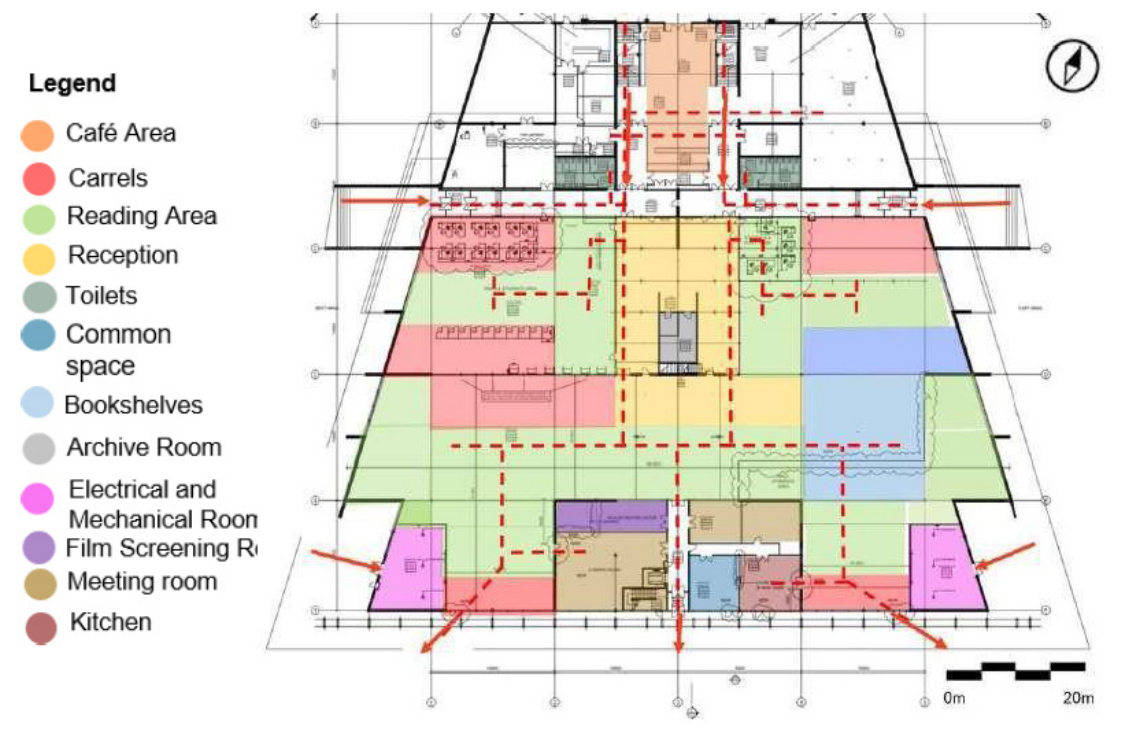
Figure 6. Plan analysis of the existing library. Figure 6 . Plan analysis of the existing library.